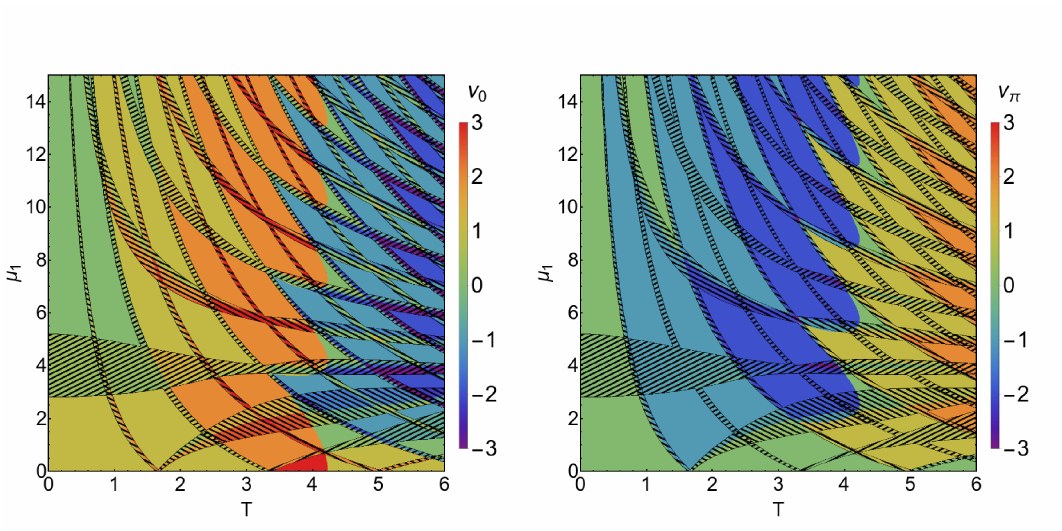
) -plane. Hatched 1 (hatch- 0